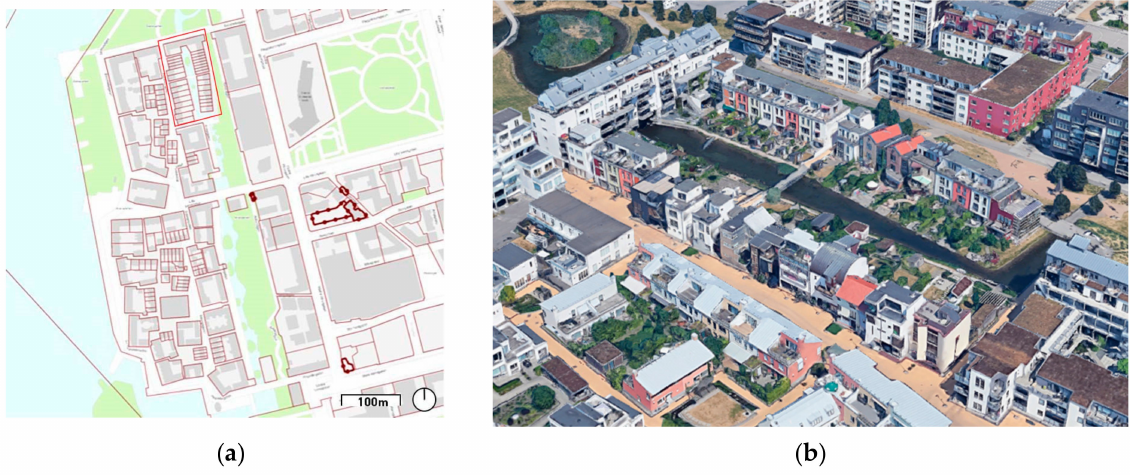
Figure 10. Overview of case study 2: ( a ) cadastral map with location of the lots [36]; ( b ) rial view of the building complex